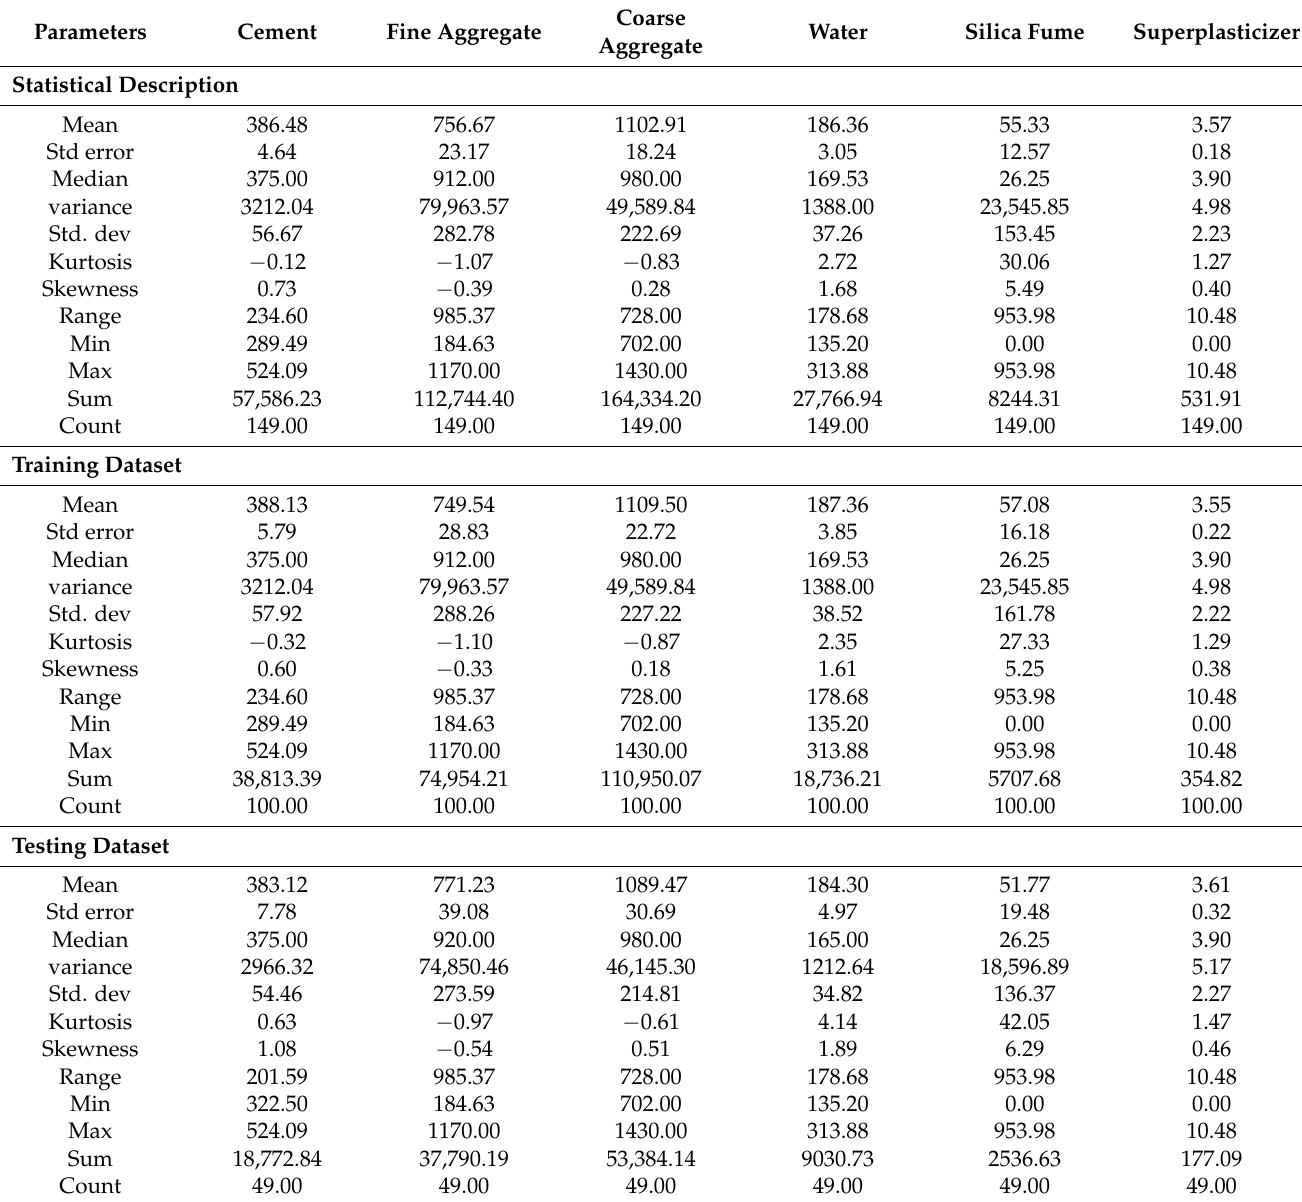
Table 3. Statistical Description of Data in the Model for Split Tensile Strength (Kg/m 3